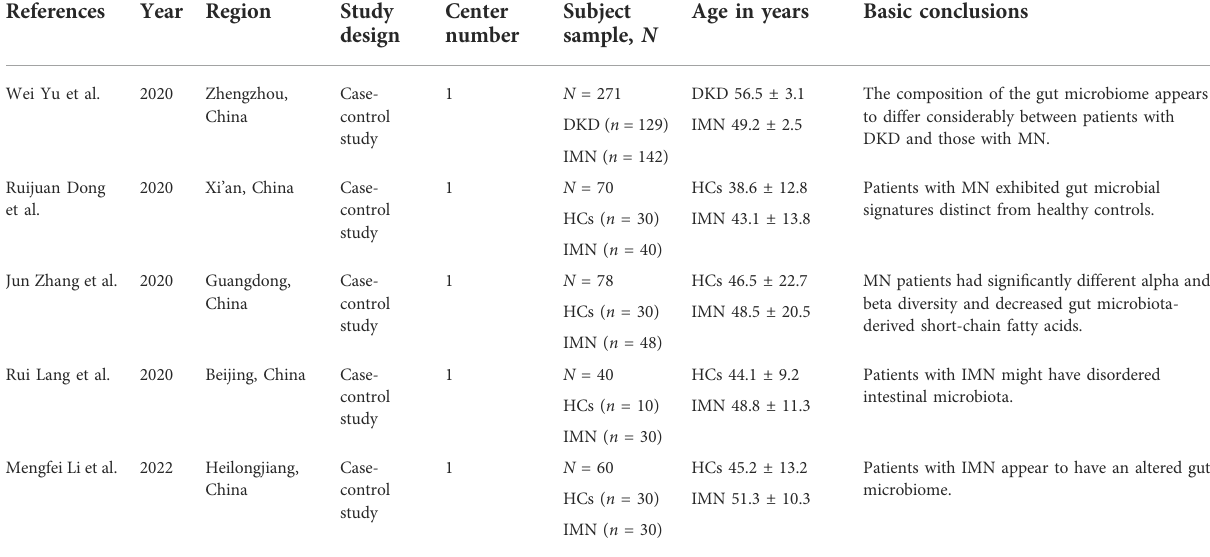
TABLE 1 Characteristics of studies included in this